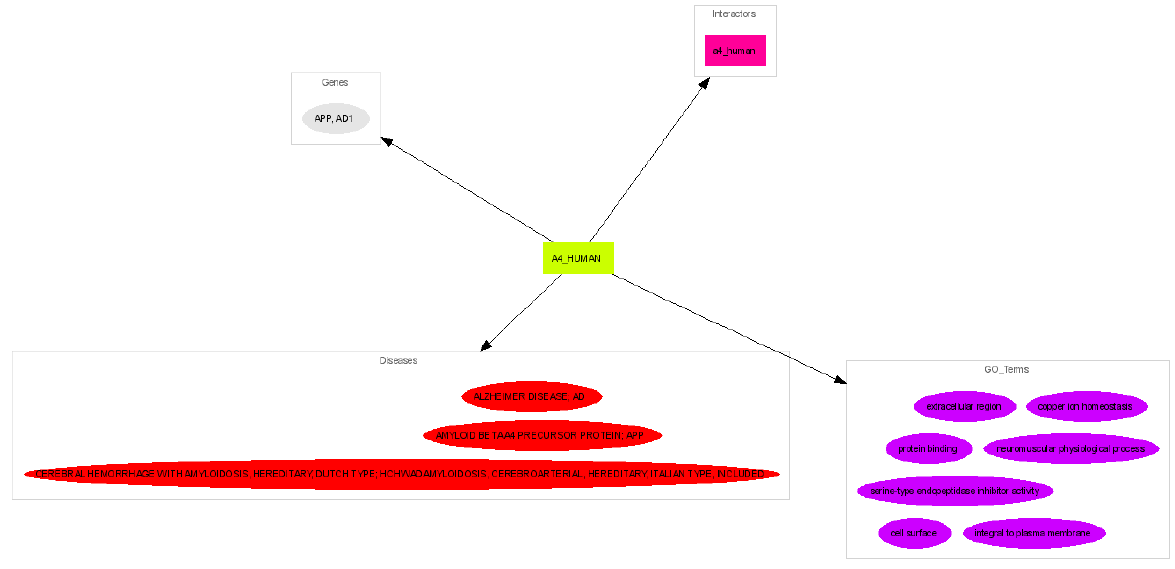
Figure 6: Amyloid beta A4 protein precursor or Alzheimer disease amyloid protein and its relation with other domains as shown in